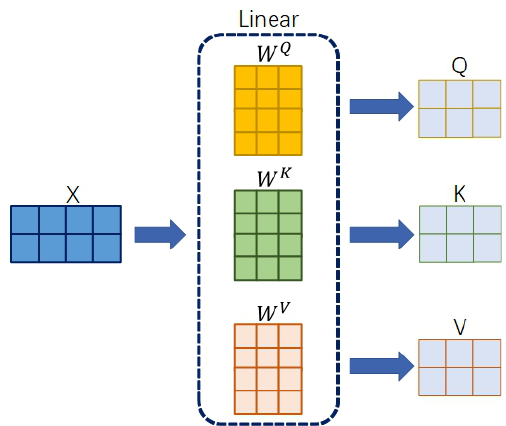
Figure 2. The generation process of Query, Key,